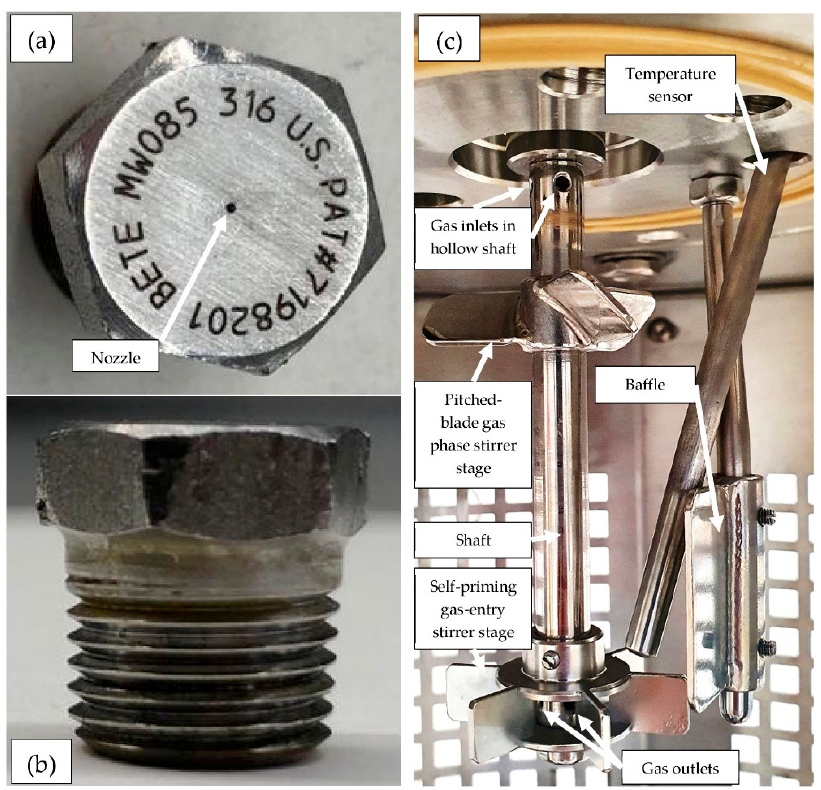
Figure 6. Reactor internals: ( a ) Micro Whirl MW85 injector nozzle, by Bete, Greenfield, MA, USA, top view, injecting a cone-shaped mist with a spray angle up to 70° and an approximate flow rate of 0.04 L/min; ( b ) Bete Micro Whirl MW85 injector nozzle, side view; ( c ) stirring equipment, clockwise direction of rotation.